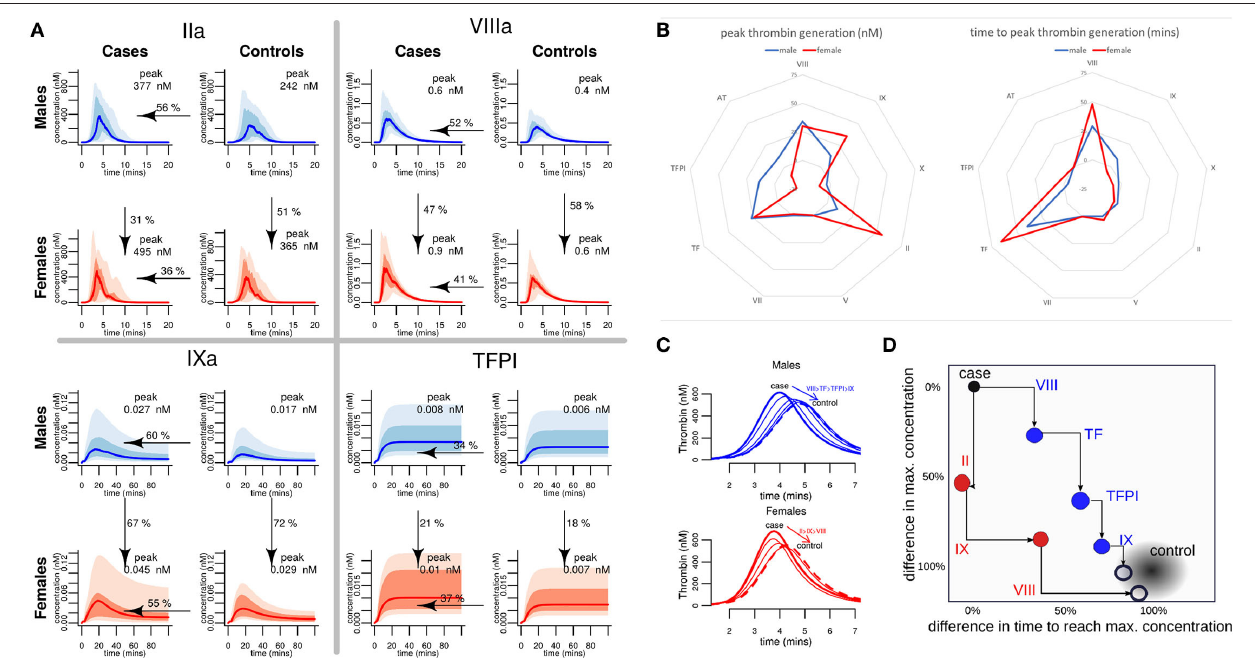
FIGURE 6 | A comparison of predicted hemostatic response in male and female MI cases and healthy controls, and identification of key drivers of the differential response. (A) Computer predicted coagulation profiles for the proteins where the divergence between the male and the female thrombotic response was greatest. Each graph shows the median values as the bold line; shaded regions depict 95% and 75% quartiles. The median peak concentration (nM) for each factor is stated in each graph. Arrows indicate the adjustment of the median value of the data from the pMI cases (as a percentage) required to match the average (mean) value in the controls. (B) Assessment of the contribution of each procoagulant protein and inhibitor to the differences in the predicted peak thrombin concentration and the time to reach this peak, for males and females. (C,D) Demonstrate the effect on the average MI donor response of sequentially adjusting the factors with the largest difference (using the values shown arrowed in panel A) to those of controls. These factors are different for males and females. In a typical male, MI donor sequentially adjusting Factors VIII, TF, TFPI, and Factor IX brings thrombin generation close to a typical control donor. In a typical female, pMI case Factors II, IX, and VIII are sequentially adjusted to bring thrombin generation close to a typical